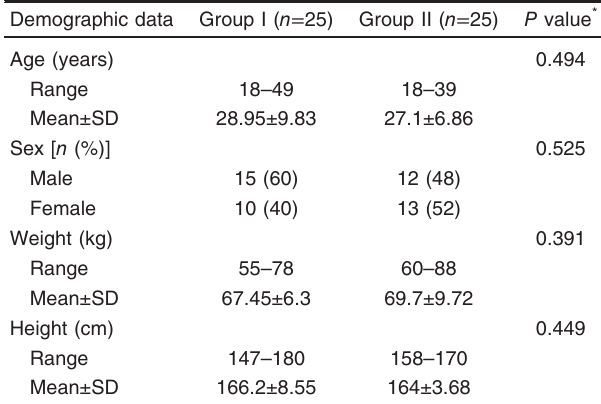
Table 3presents the distribution of chest symptoms, with chronic cough being the most frequent symptom. Table 1 Population characteristics in group I versus group II